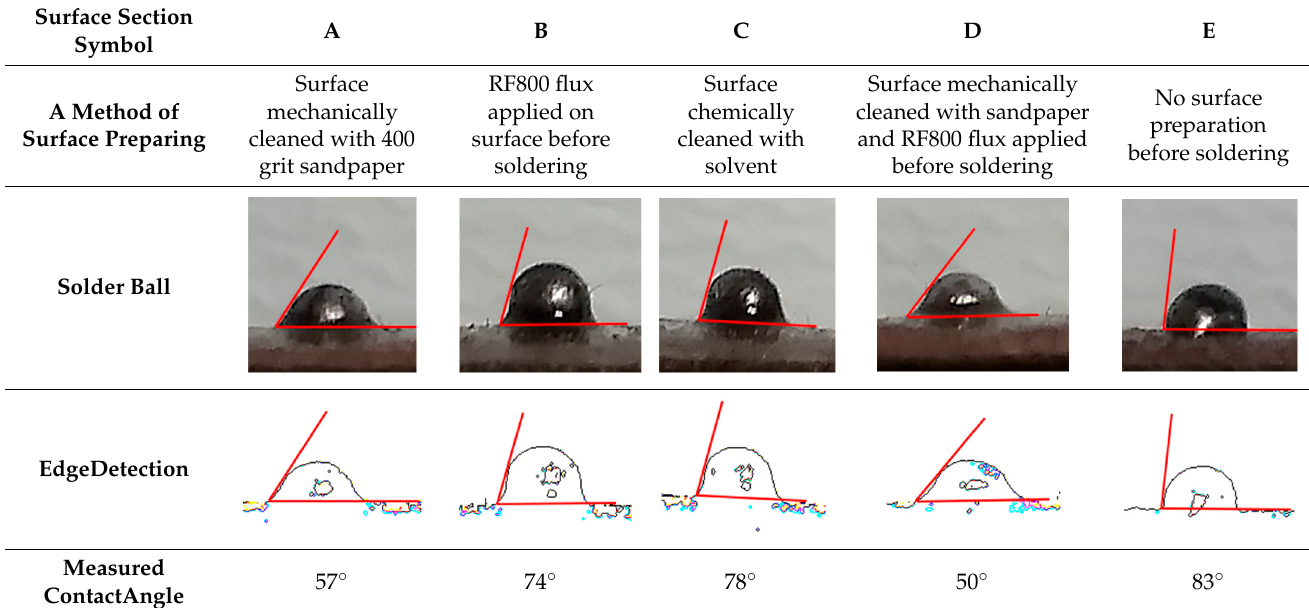
Table 2. Contact angle measurements results of SnBiAg solder correlated with the surface preparation of ABS/Cu composite. Surface Section